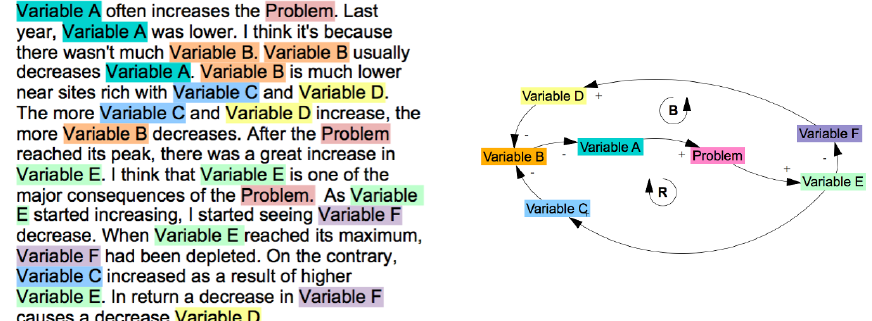
Figure 5. A simplified version of a storyline and its corresponding CLD.